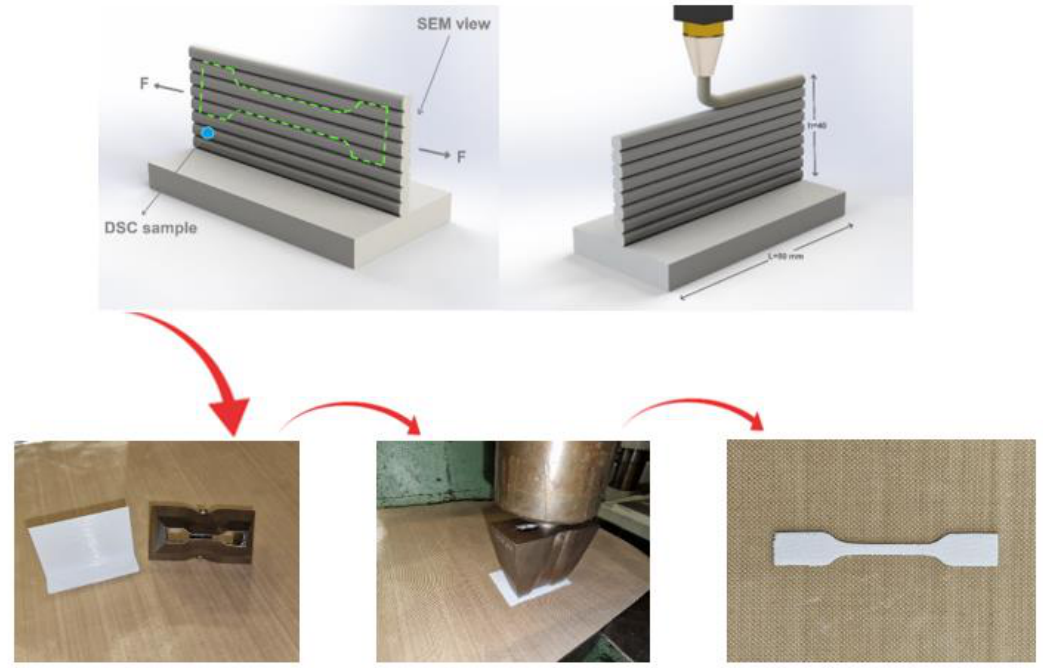
Figure 1. The printed single-wall specimens and preparation of the tensile test specimens [5] .